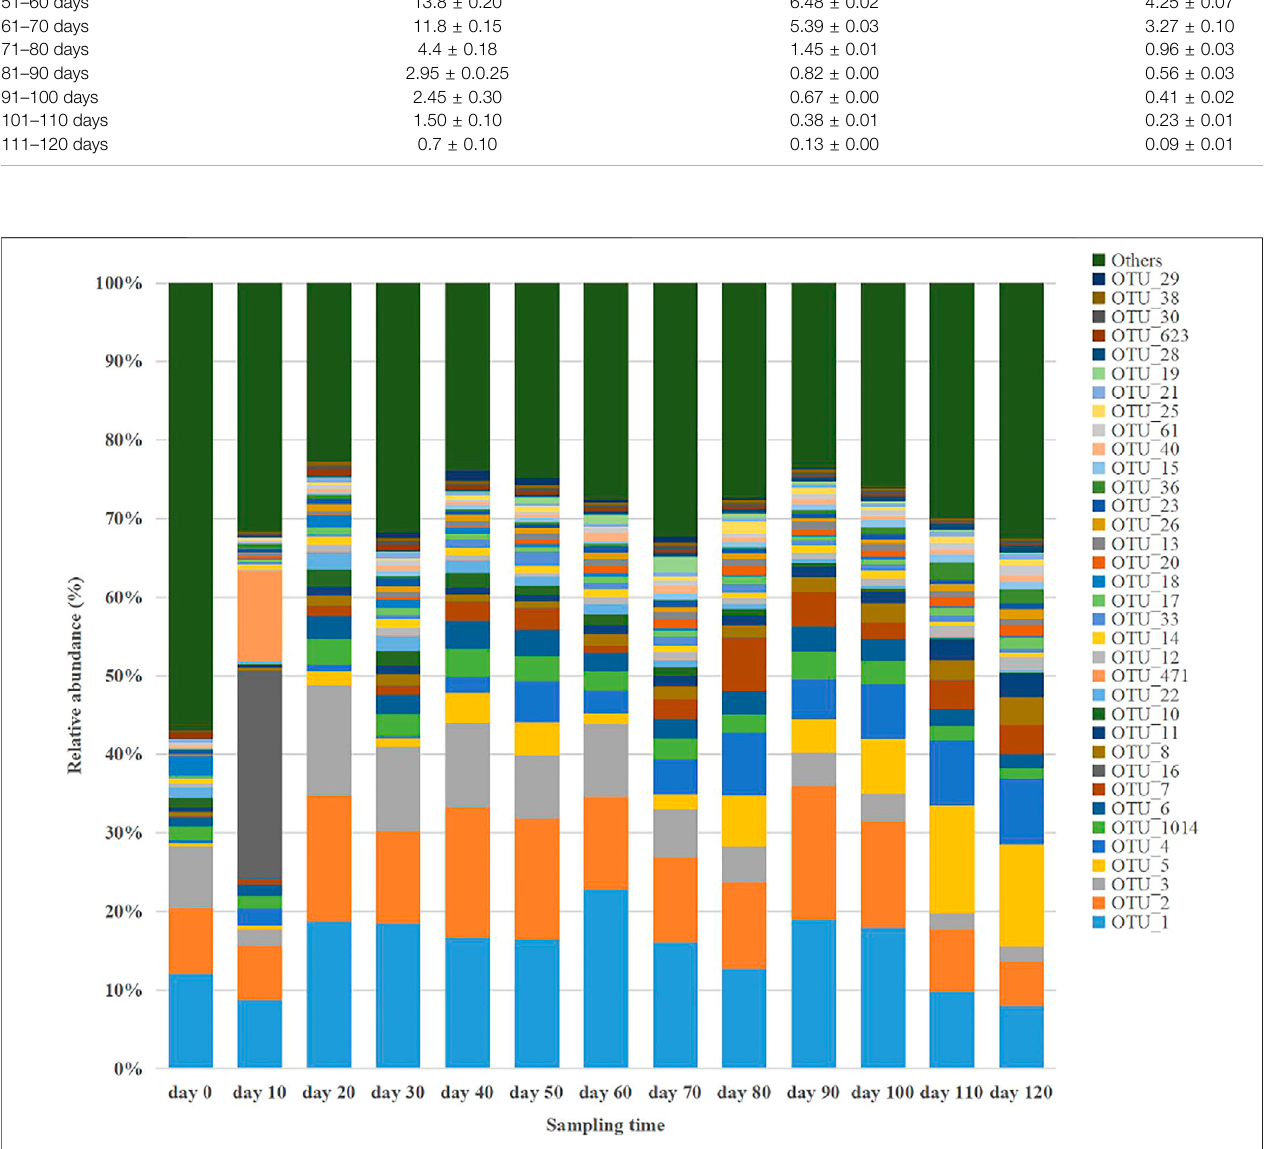
Frontiers in Energy Research |